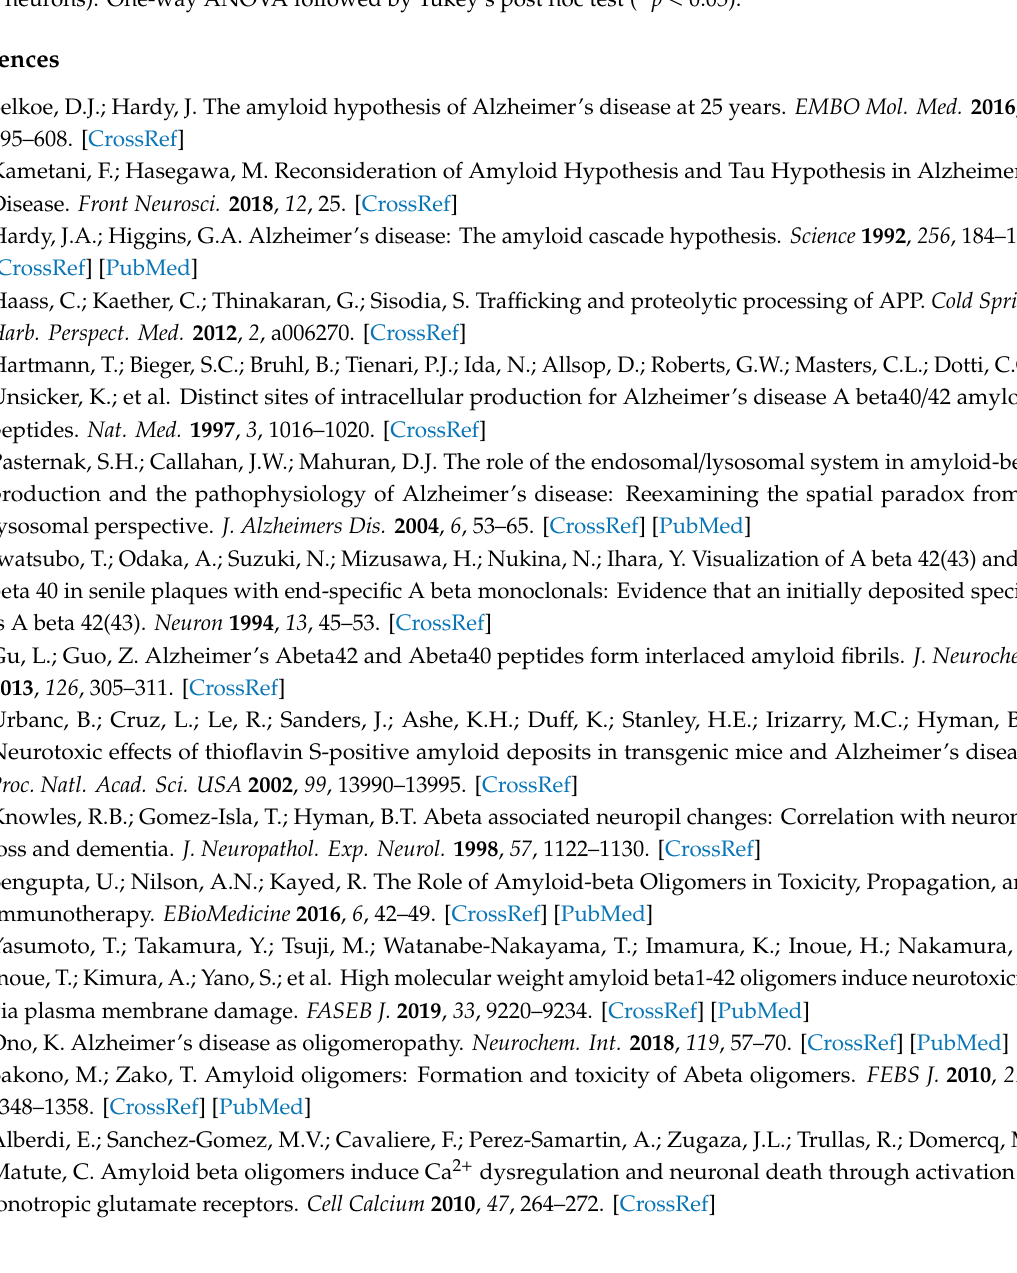
Figure A4. Integrated density of Total STAT3 immunoreactivity / neurons. Data are means ± SEM ( n = 4, 3 neurons). One-way ANOVA followed by Tukey’s post hoc test (* p <